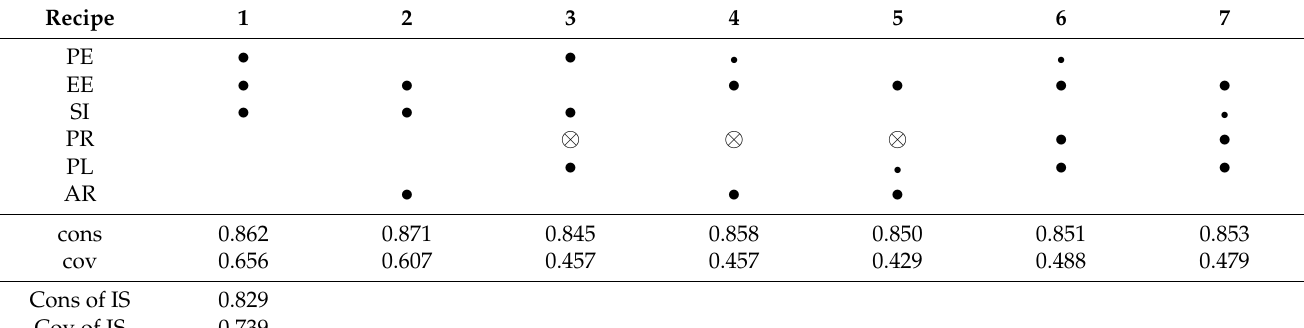
Table 5. fsQCA intermediate solution (IS) ACCEPT = f (PE, EE, SI, PR, PL, AR).